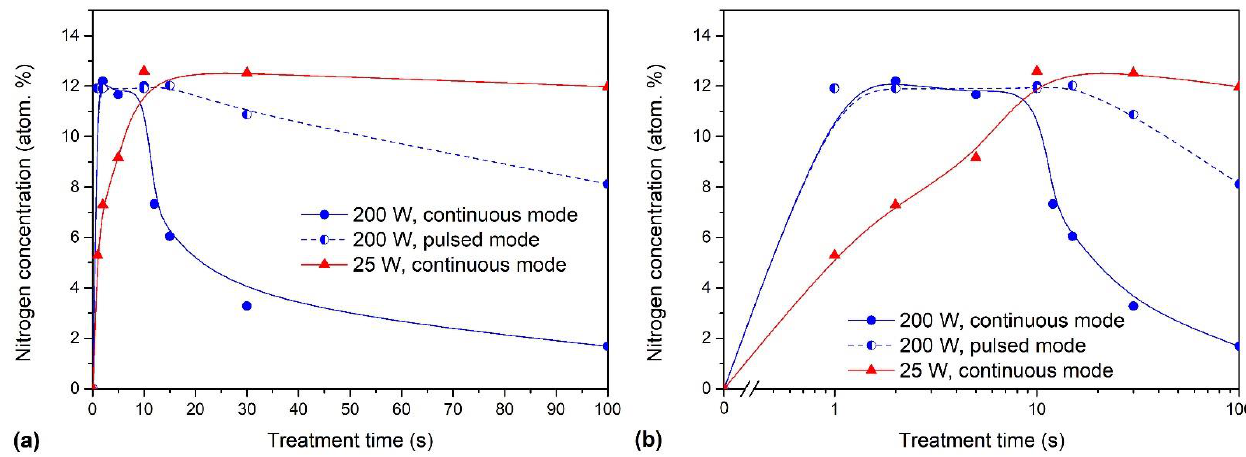
Figure 5. The concentration of nitrogen versus treatment time in ammonia plasma: ( a ) linear and ( b ) logarithmic scale. All samples were pretreated with hydrogen plasma at 35 Pa, 600 W for 1 s.